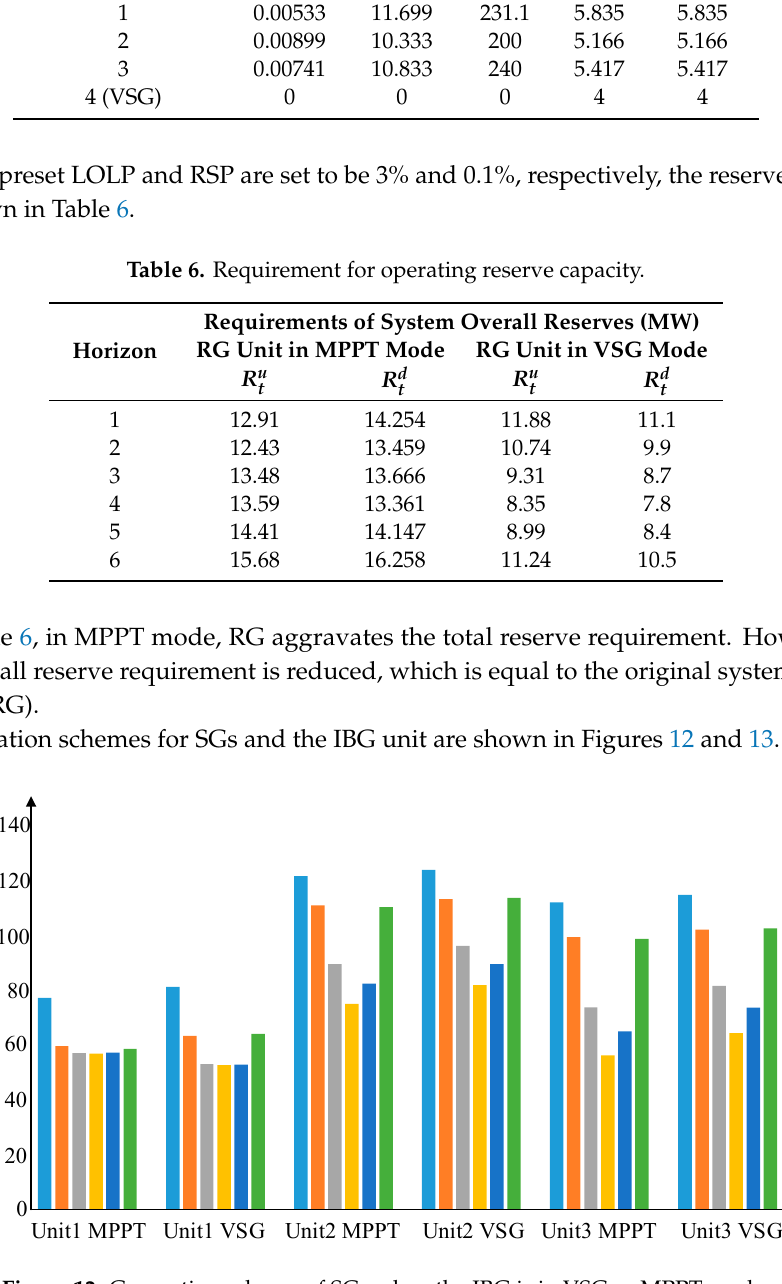
Figure 12. Generation scheme of SGs when the IBG is in VSG or MPPT mode.